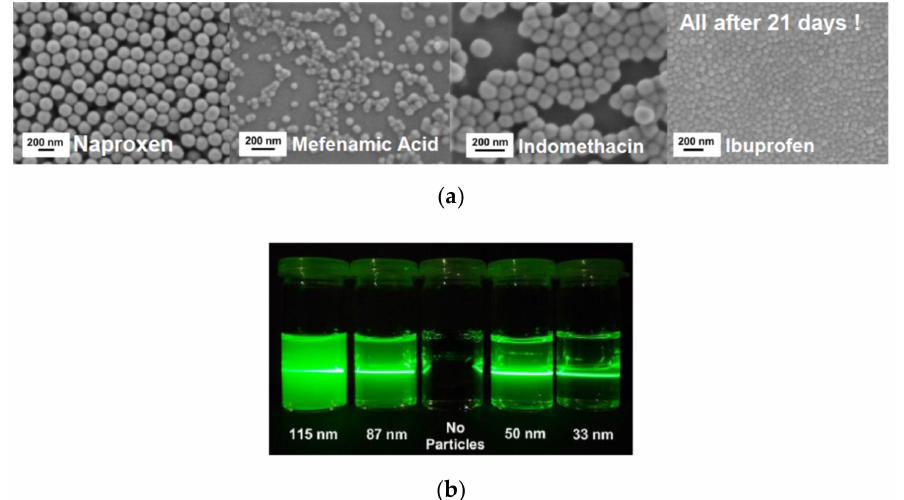
Figure 7. ( a ) Four different sub-100 nm, quasi spherical, and uniform amorphous organic drug nanoparticles (ONP) obtained by precipitation (SEM micrographs taken 3 weeks after production). ( b ) Tyndall effect to demonstrate the small particle size for Ibuprofen by reduced light scattering, particularly for the 33 nm particles.